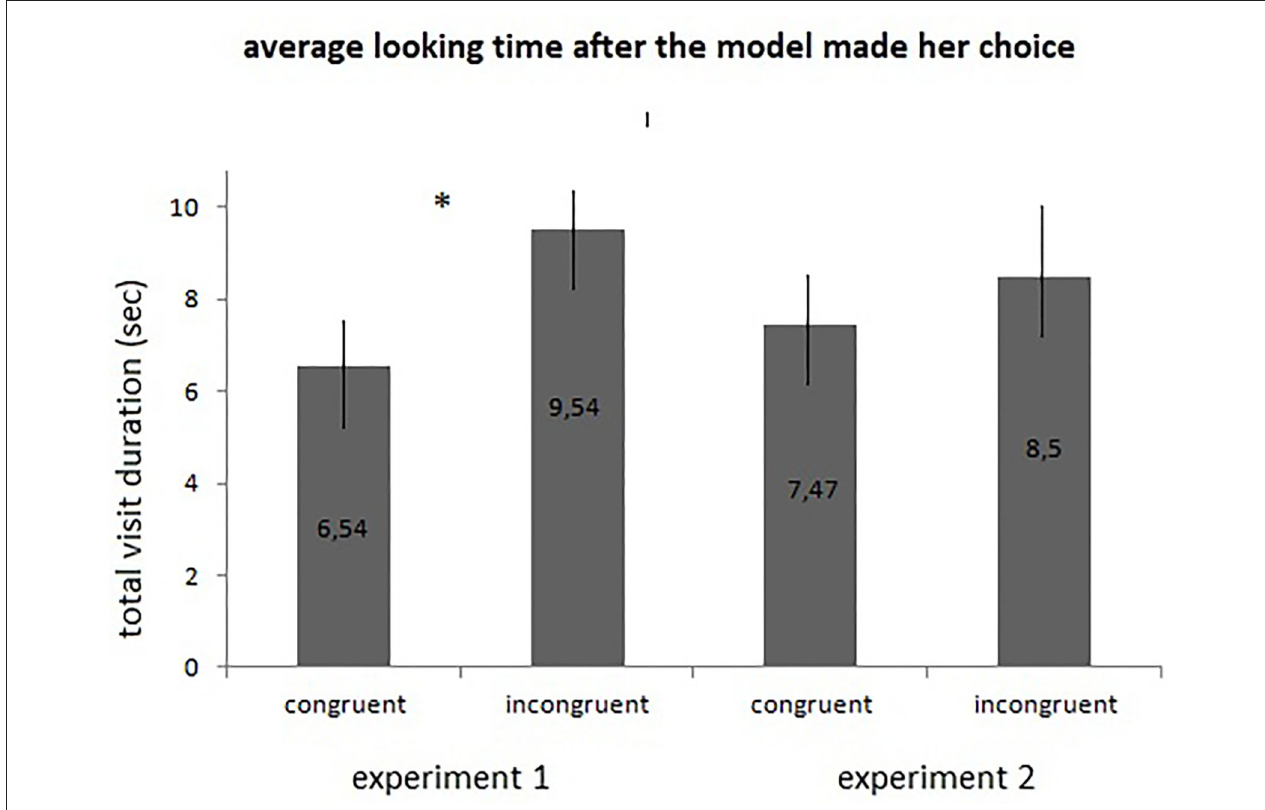
FIGURE 3 | Looking times for experiment 1 and 2. This graph depicts the average looking time after the model made her choice. The asterisk indicates the significant difference which was revealed by Mann-Whitney U Test in case of Experiment